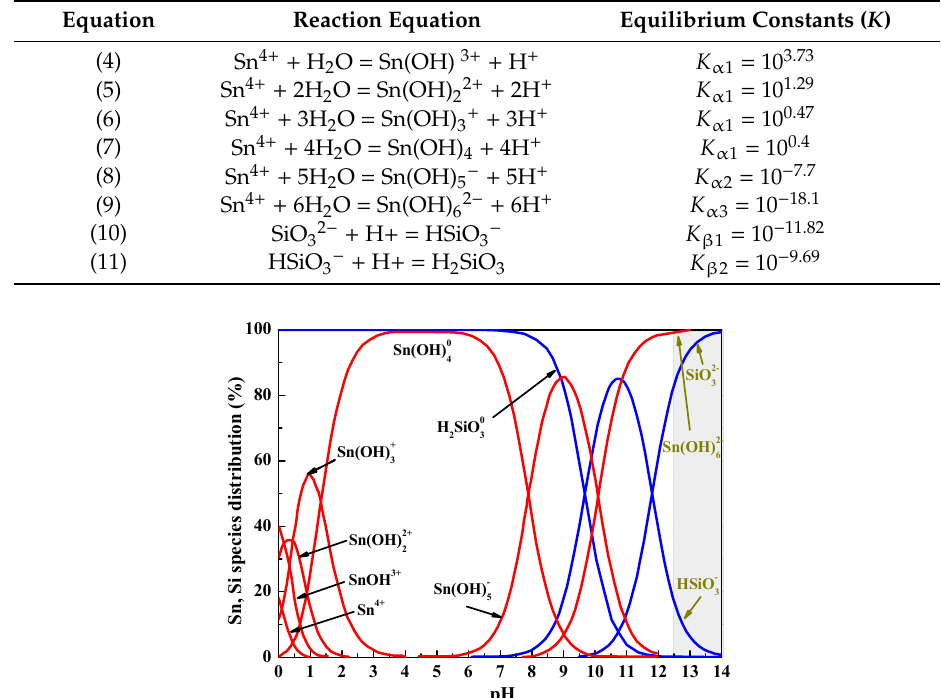
Figure 6. XRD pattern of the leach residues (Sample 2# in Figure 3). Table 2. Reaction constants for equilibrium reactions of Si(IV) and Sn(IV) species.